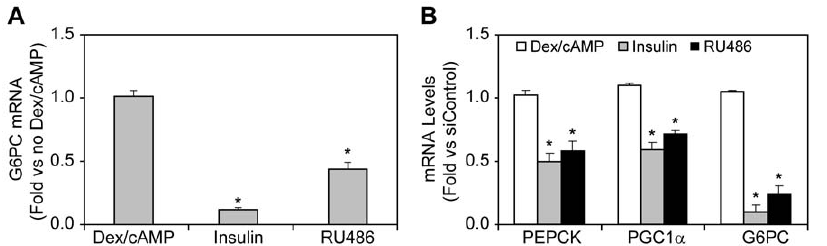
Figure 7. Pharmacological inhibitor of glucocorticoid receptor (GR) led to similar reduction of gluconeogenesis gene expression to GR siRNA in AH-G6PC cell. AH-G6PC cells were preincubated with or without the GR antagonist RU486 (5 m M) for 18 h. The cells were then incubated with Dex/cAMP alone, Dex/cAMP plus 400 nM insulin, or Dex/cAMP plus RU486 (in the cells treated with RU486 overnight) for 6 h. A. Taqman analysis was performed on mRNA isolated from the cells to assay G6PC mRNA relative to Dex/cAMP treated cells. B. Multiplex HTG ArrayPlate analysis of mRNA isolated from the cells was used to quantify PEPCK, PGC1 a , and G6PC mRNA expression. Data are plotted as fold change vs. mRNA levels in cells treated only with Dex/cAMP and are the means 6 SEM of 3 independent experiments.